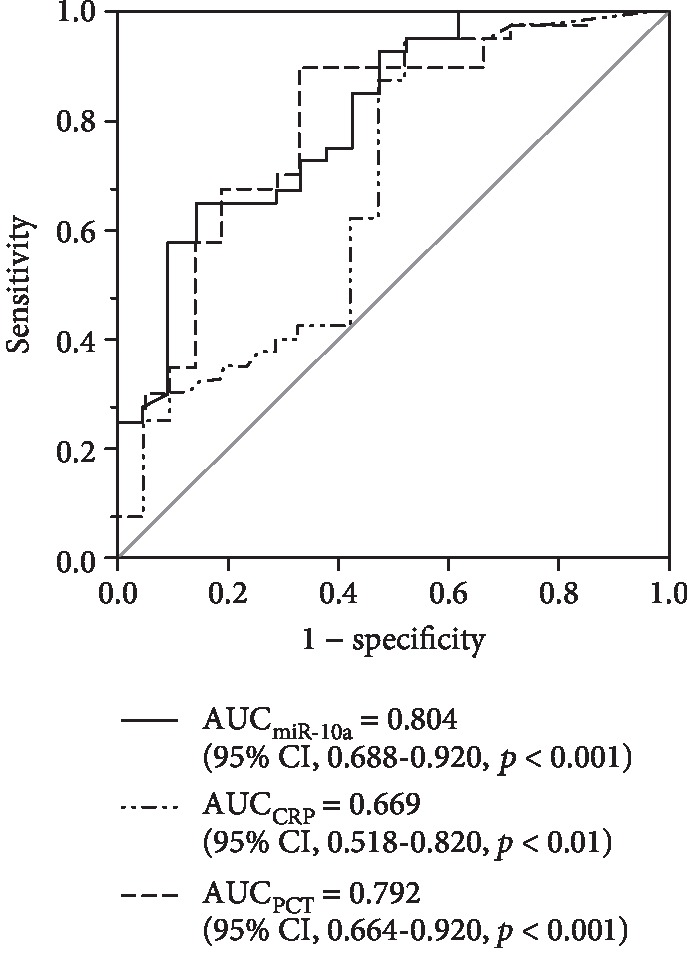
ROC curves for the prediction of sepsis. ROC curves present sensitivity and specificity of PBMC miR-10a, CRP, and PCT for predicting sepsis.